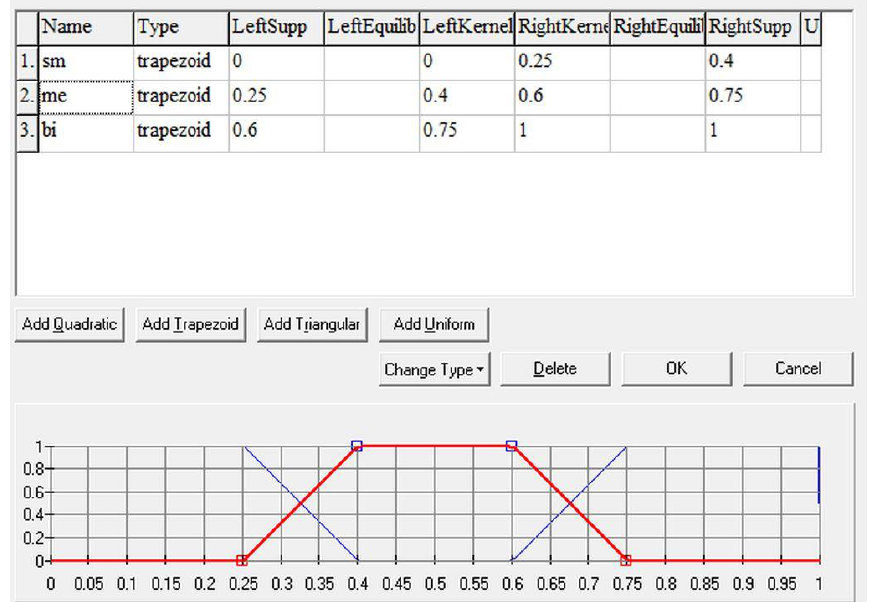
Figure 3. Graphic representation of the input value set V2.